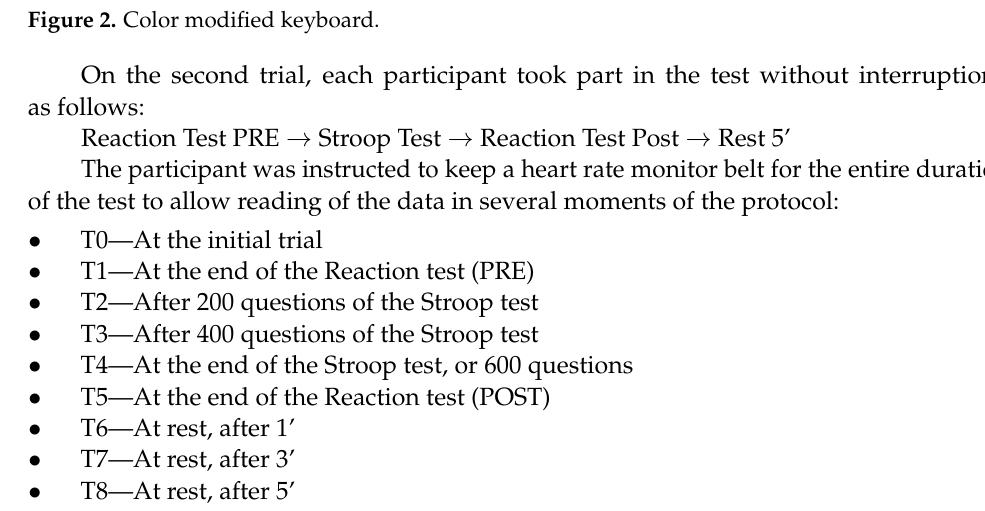
Figure 2. Color modified keyboard.